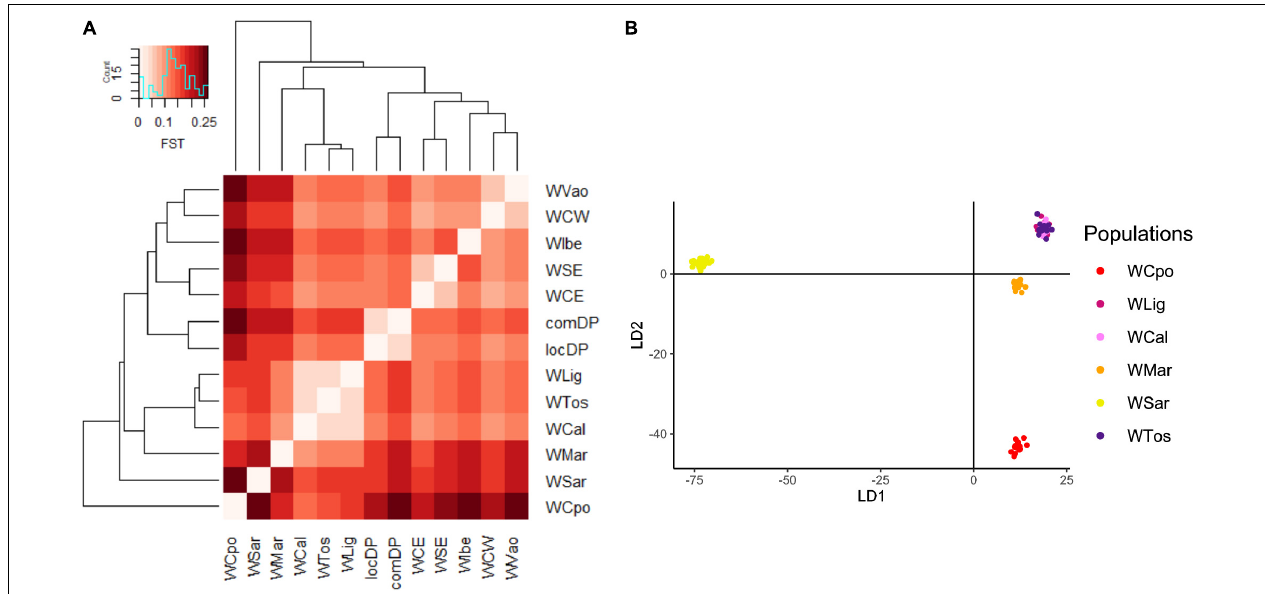
FIGURE 3 | Genomic differentiation among Italian wild boar populations expressed by (A) Pairwise F ST heatmap and (B) Discriminant Analysis of Principal Components (DAPC). WVao population was excluded from the DAPC because of its clear assignment to non-Italian populations ( Figure 2 ). The most